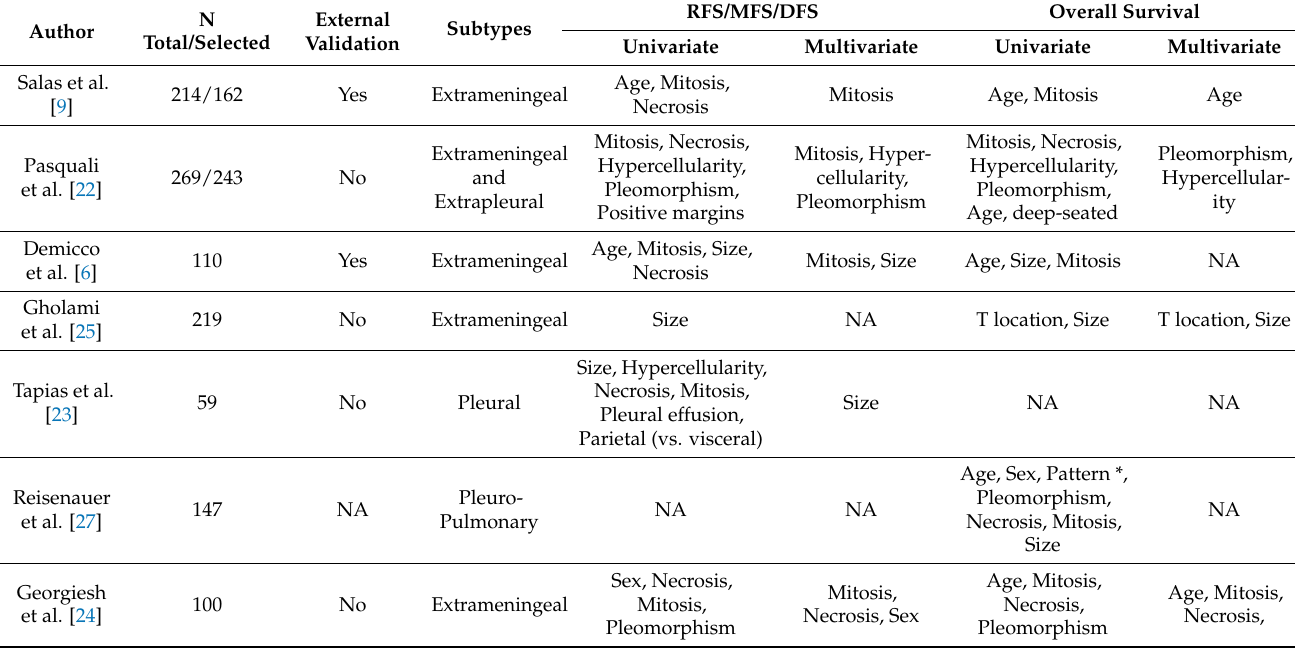
Table 1. Univariate and multivariate analysis of series (analyzed localized resected